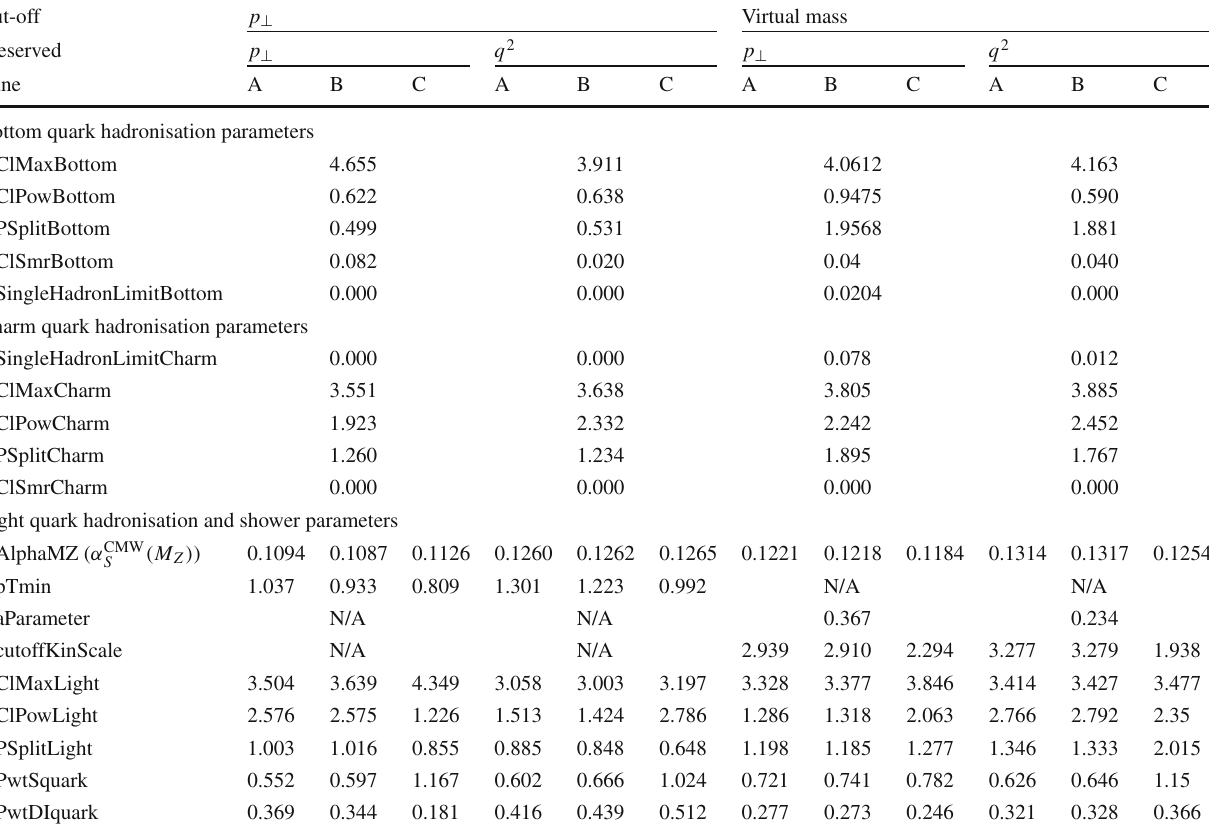
Table 1 The Monte Carlo parameters obtained for different choices of the cut-off option, the preserved quantity in the shower and weight of the charged particle multiplicity data Cut-off p ⊥ Virtual